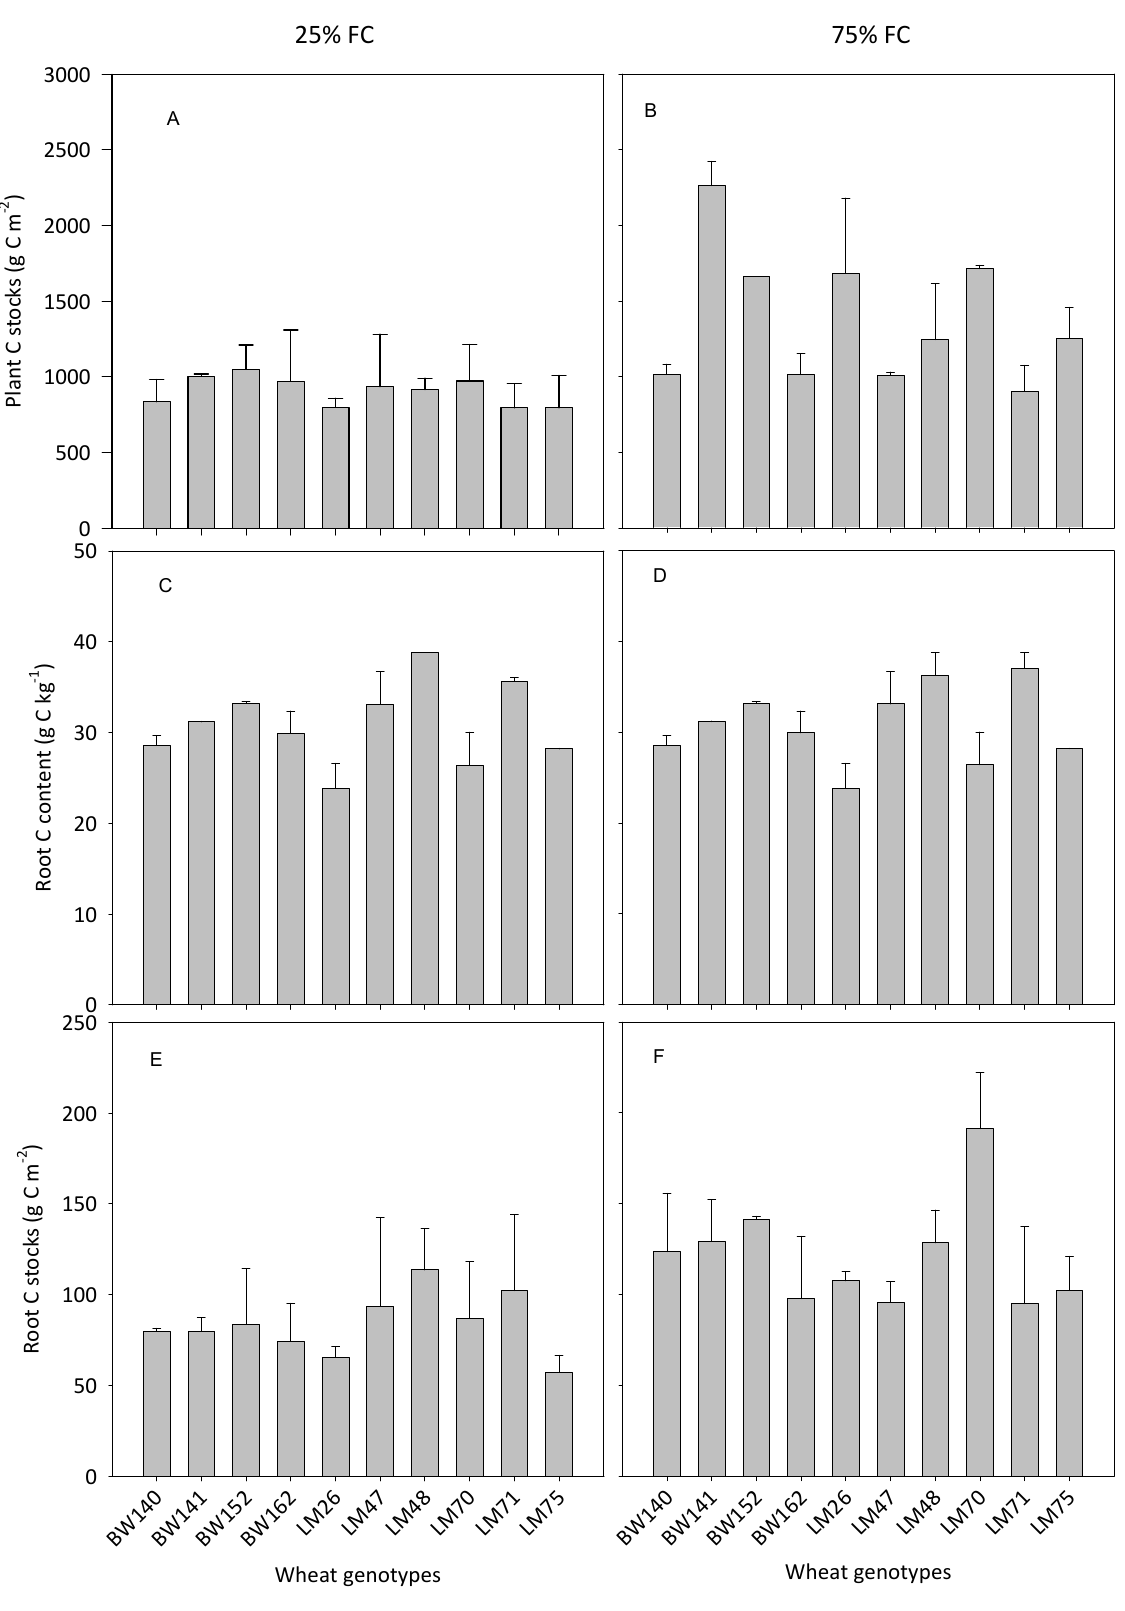
Figure 4. Variation in plant C stocks ( A , B ), root C content ( C , D ) and root C stocks ( E , F ) due to genotype and soil water availability (25 and 75% field capacity) under field conditions. Data are mean and standard errors (n = 9).